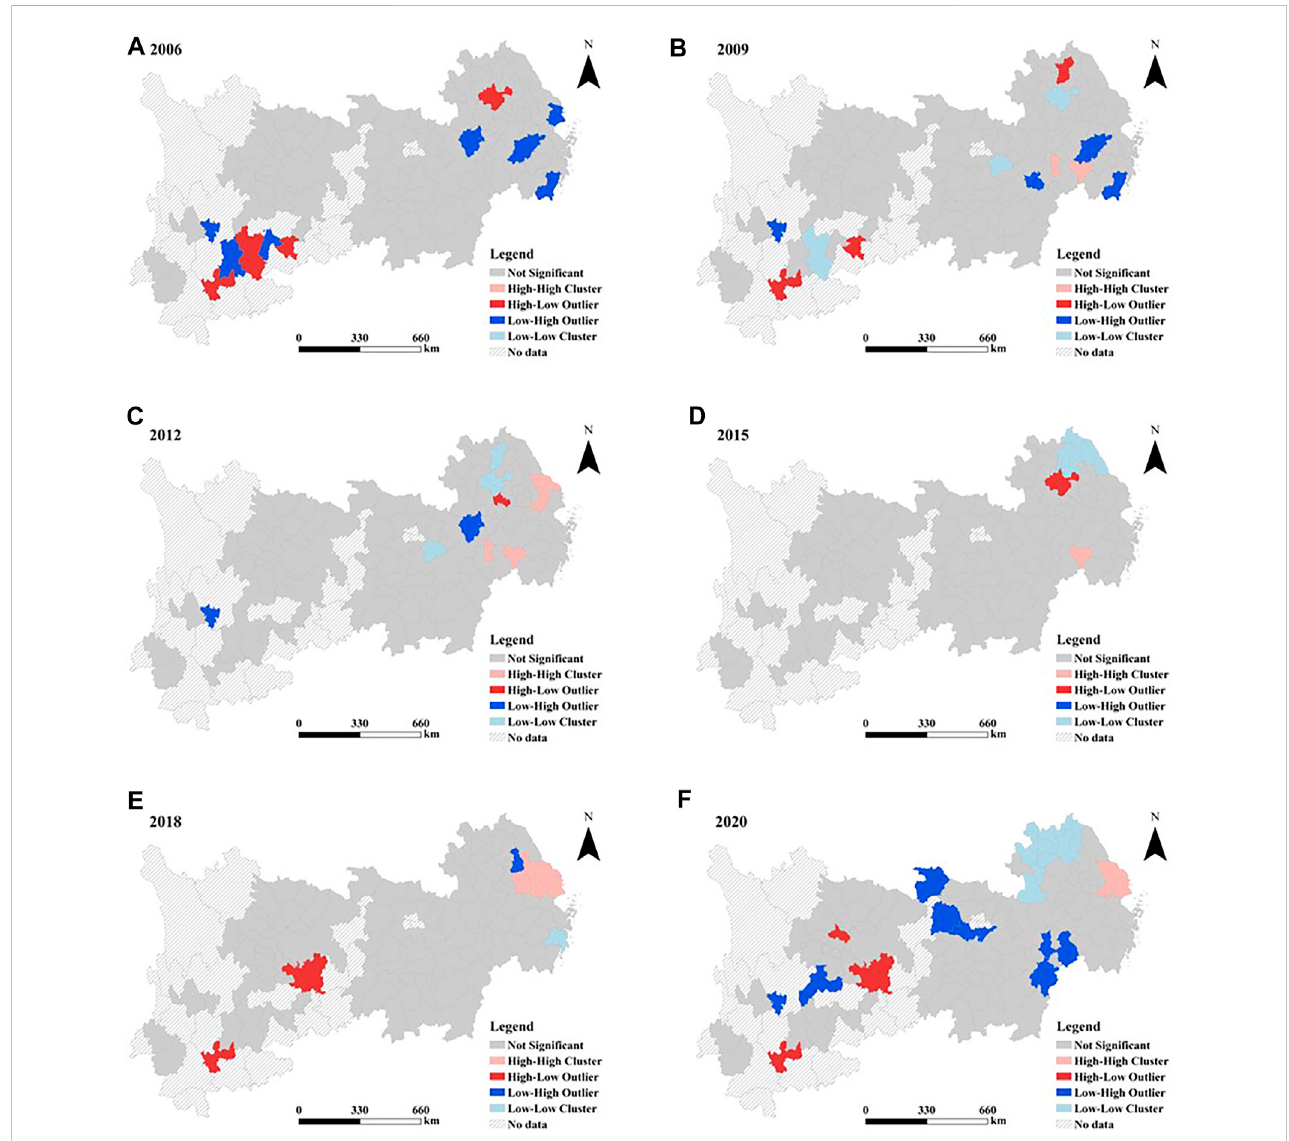
FIGURE 6 Localspatial agglomeration mapofULUE intheYREB (A – F) representsthelocalcorrelationofULUEofYREBin2006,2009,2012,2015,2018,and2020,